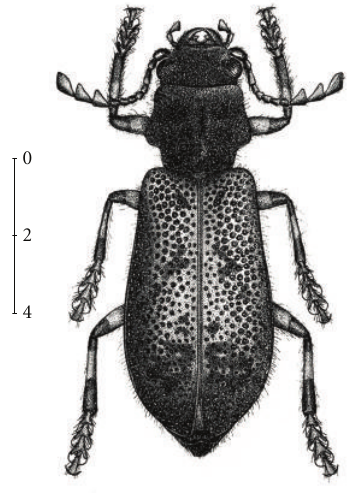
Figure 9: Habitus of Neopylus nahuelbutensis .